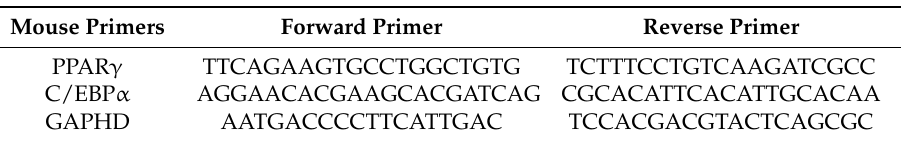
Table 6. Primer sequences used for real-time